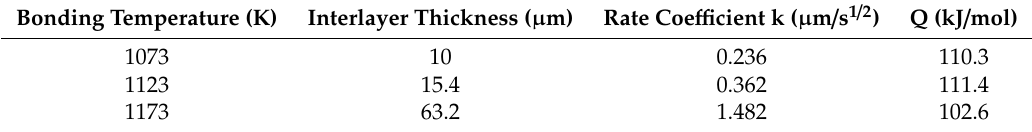
Table 3. Growth kinetics of the reaction Cu 2 Ti layer during the di ff usion bonding process.